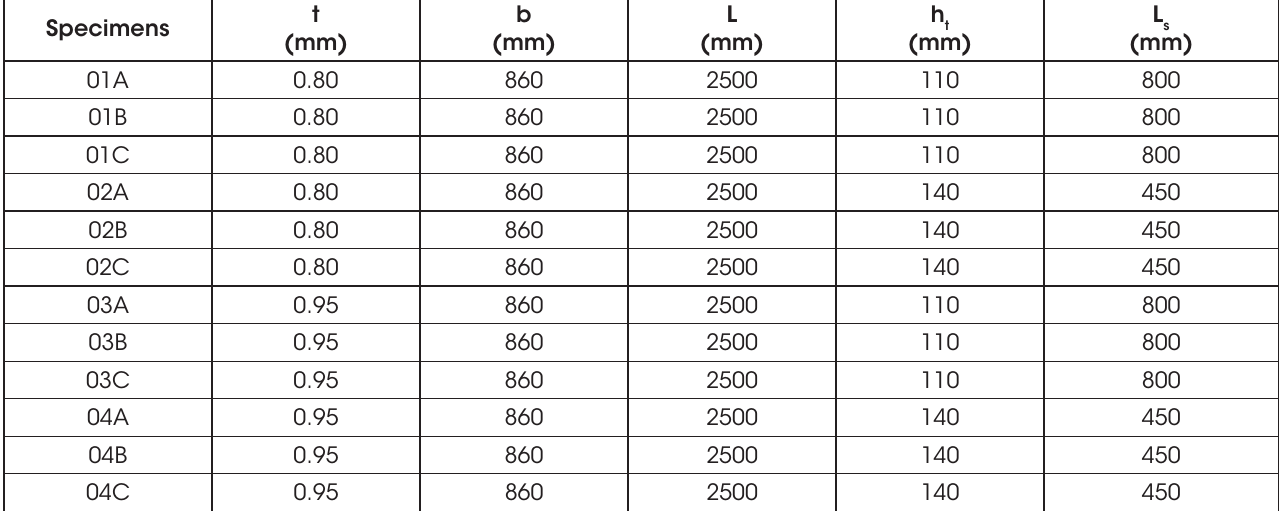
Geometrical characteristics of test